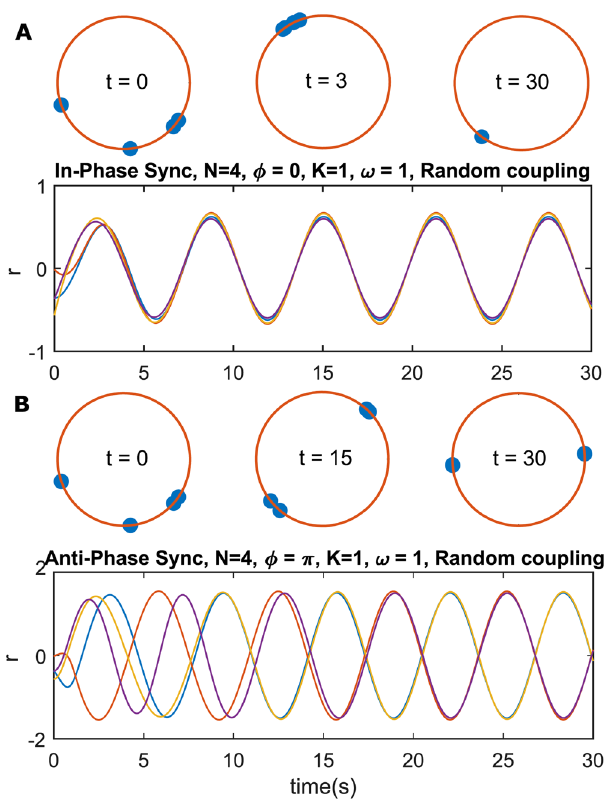
Figure 1. Illustration of in-phase and anti-phase synchronization. 4 identical Stuart-Landau oscillators with ( A ) purely attractive and ( B ) purely repulsive coupling, with random coupling-strengths between nodes. ( A ) exhibits in-phase synchronization and ( B ) exhibits anti-phase synchronization. t is time measured in seconds. The red circles show the evolution of the phase of the oscillators with time. Once locked in their respective synchronized states, both A and B remain in the same state